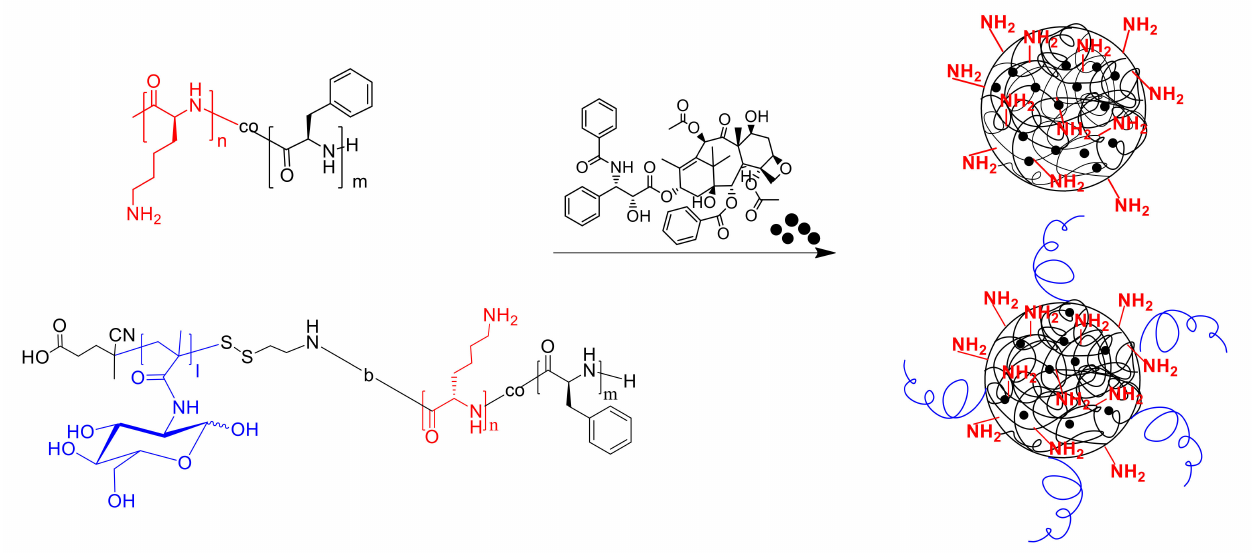
Figure 12. Schematic representation of paclitaxel-loaded NPs